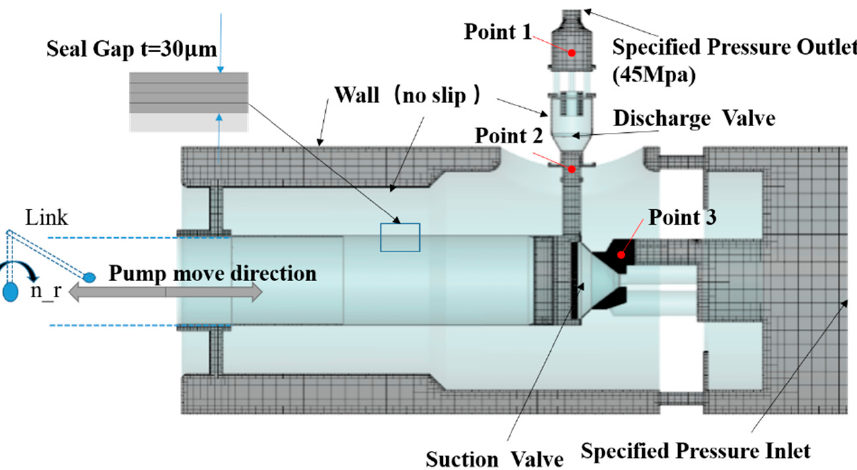
Figure 5. Boundary conditions for the simulation of unsteady flowfield of reciprocating pump.